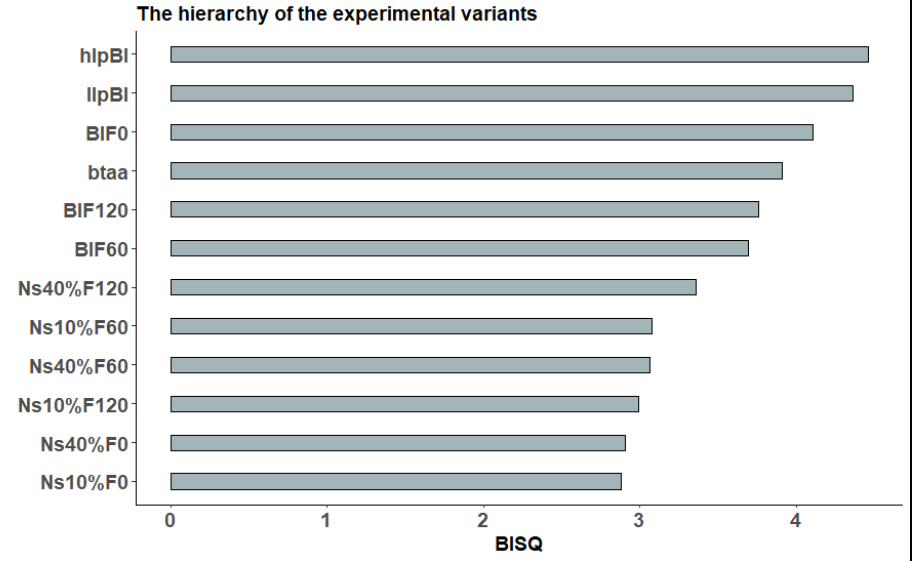
Figure 3. The hierarchy of the experimental variants according to the values of the bacterial indicator of soil